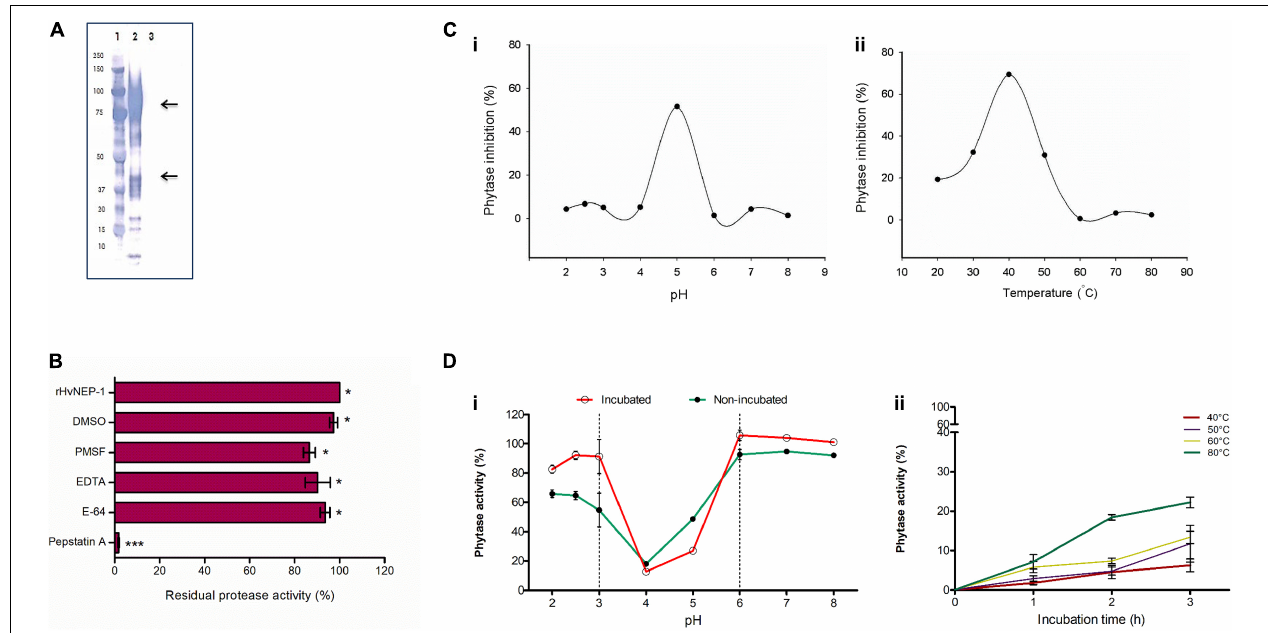
FIGURE 3 | Cloning and characterization of HvNEP-1 from grains of barley cv. Invictus. (A) Western blot analysis of the rHvNEP-1 protein. Lane 1: protein standard, lane 2: rHvNEP-1, and lane 3: supernatant of untransformed Pichia KM71H strain. Two strong protein bands that correspond to approximately 47 kDa and 92 kDa are indicated with arrows. (B) Residual activity of rHvNEP-1 after incubation with generic protease inhibitors. (C) pH (i) and temperature (ii) optima of rHvNEP-1 to inhibit the activity of A. ficuum phytase. Lines connect the mean of each consecutive treatments. (D) The effect of pH (i) and temperature (ii) on the stability of rHvNEP-1 activity. pH and temperature stabilities are described as percent residual activity of A. ficuum phytase in the rHvNEP-1 incubated and non-incubated samples. Values in (B–D) are the mean of three independent technical replicates. Error bars = mean ± SE ( n = 3), * p < 0.05 and *** p <